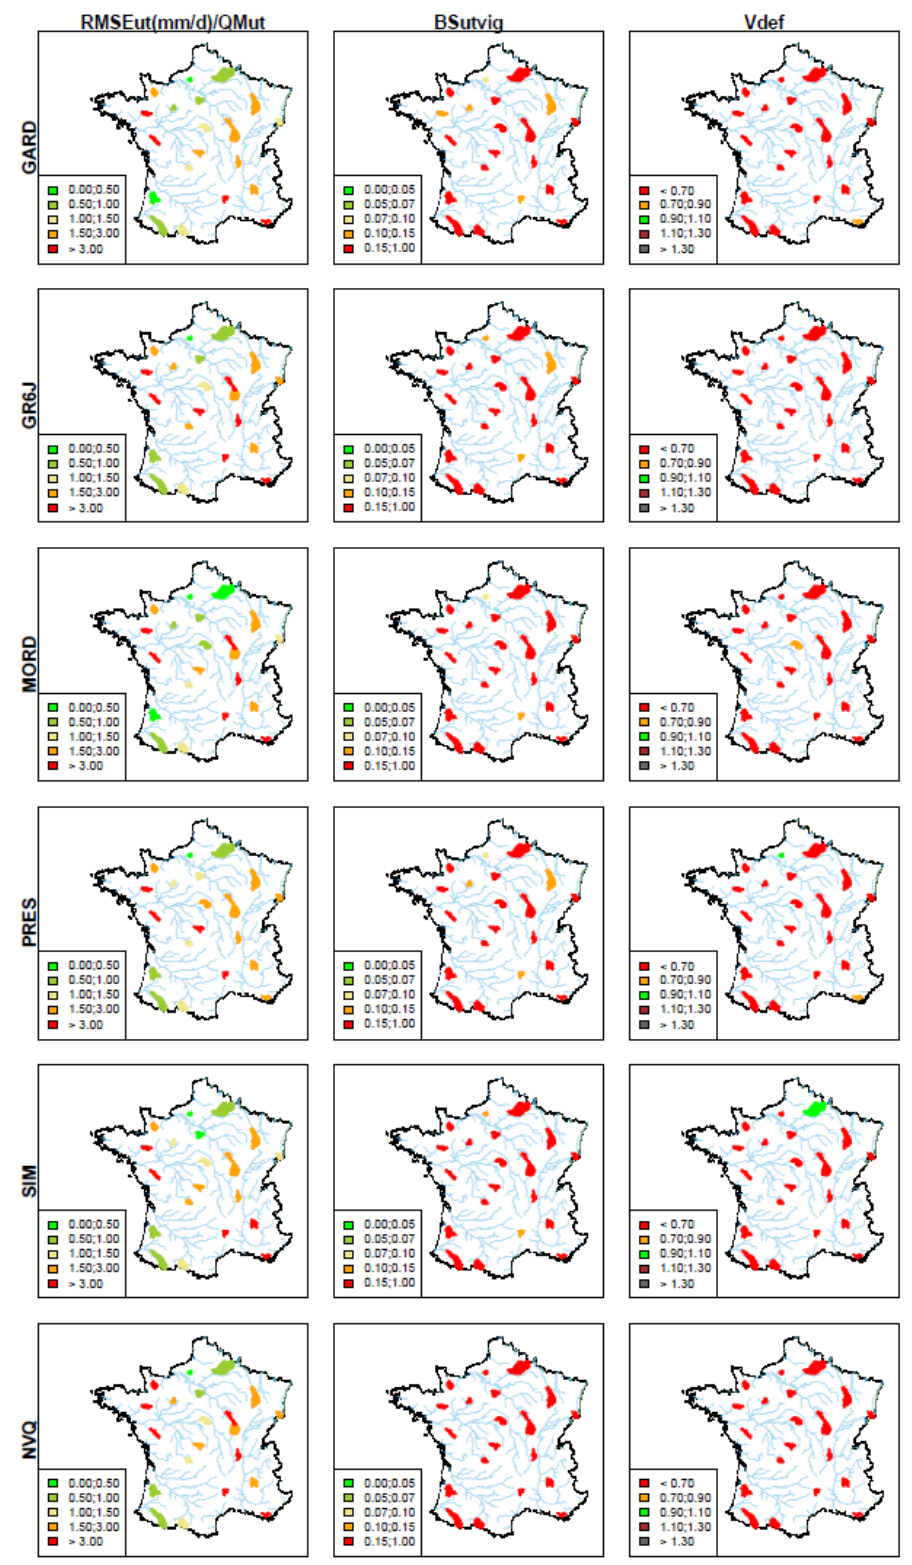
Figure 11. Model performance if forecasting mode on validation period 2 for the RMSE ut , BS vig and Vdef criteria for each model on the 21 catchments for a 30 day forecasting lead